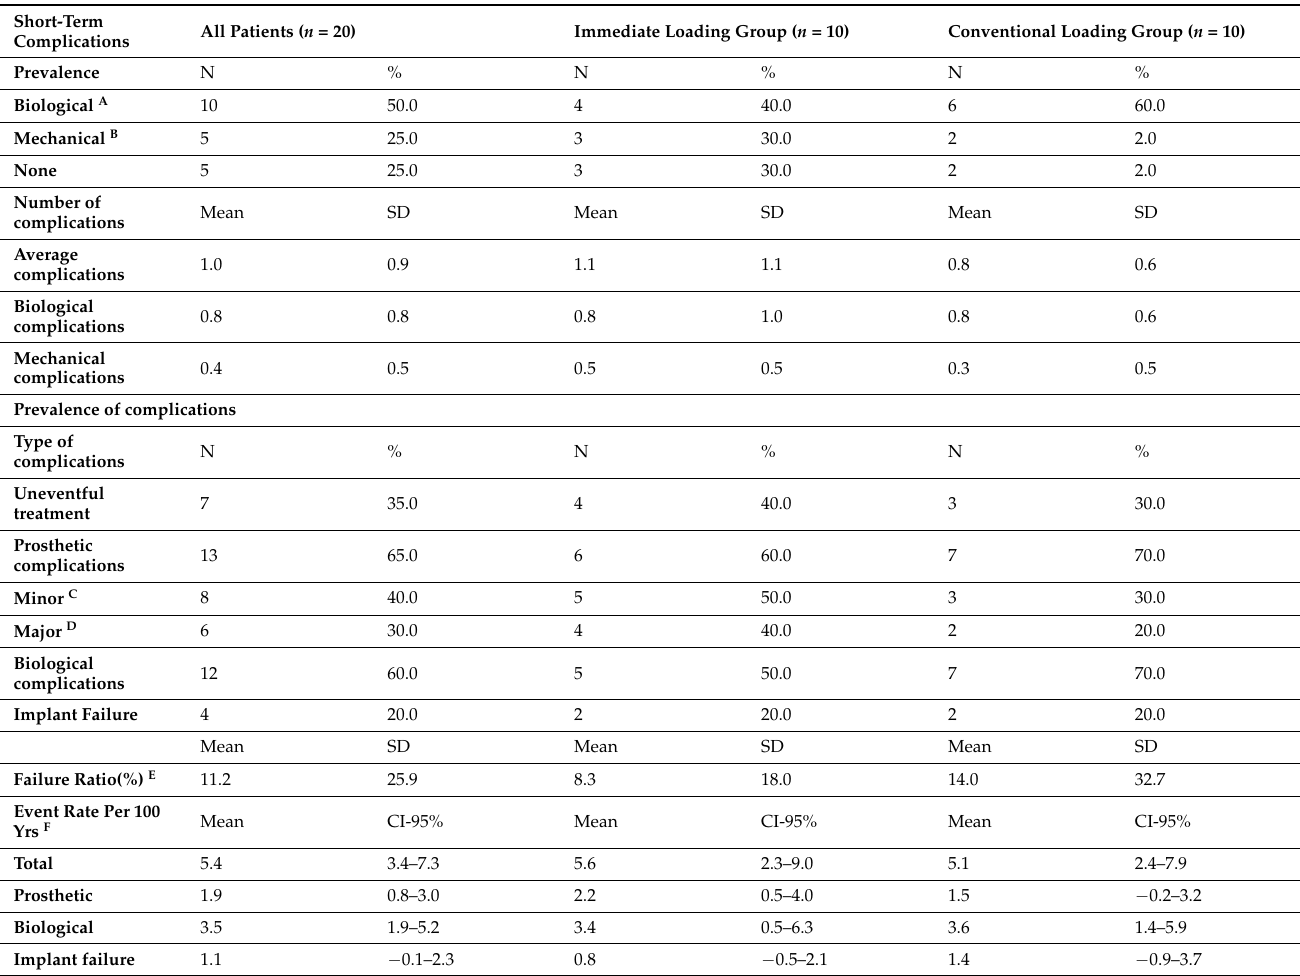
Table 4. Prevalence and rates of biological, mechanical, and technical complications among the study sample ( n =